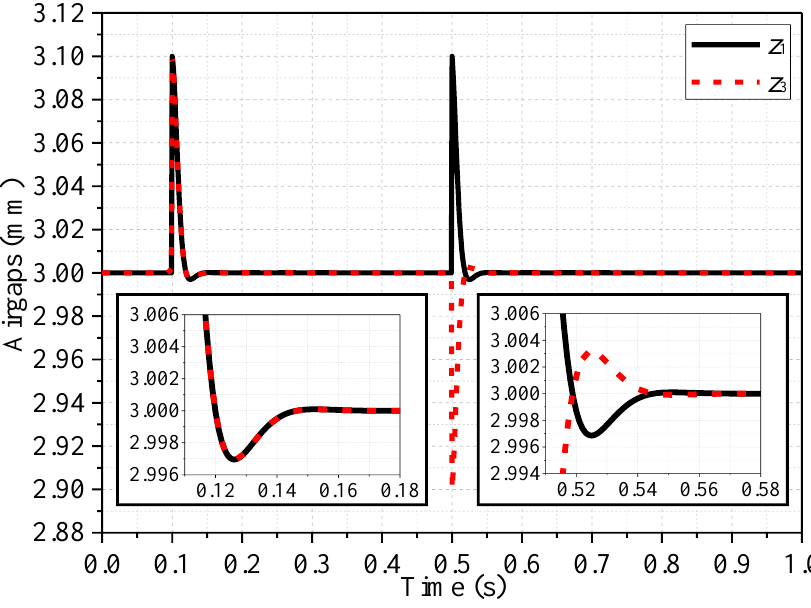
Figure 10. Simulation result.